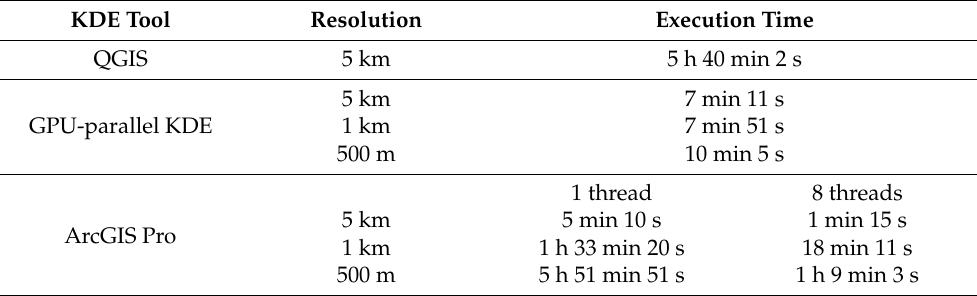
Table 2. Execution time of the KDE tools to estimate density surfaces at varied spatial resolutions using the 2019 iNaturalist data ( n = 11,986,484 points) with a fixed bandwidth. Higher spatial resolution represents KDE task involving larger datasets. The KDE tool in Pro were run with both one thread and eight threads. Experiments were conducted on the server computer running Windows Server 2016 with a NVIDIA Tesla